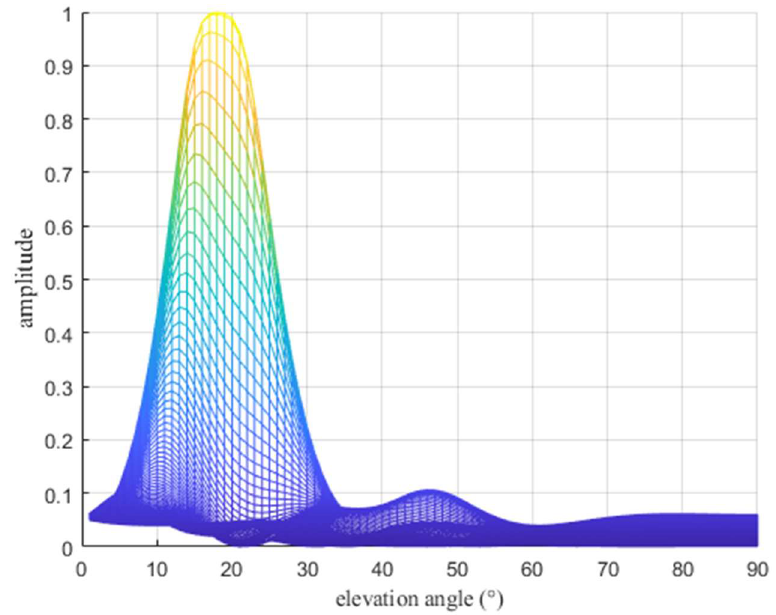
Figure 4. Illustration of spatial spectrograms with elevation angles of 16.4° and 20.5° under two paths (elevation view).